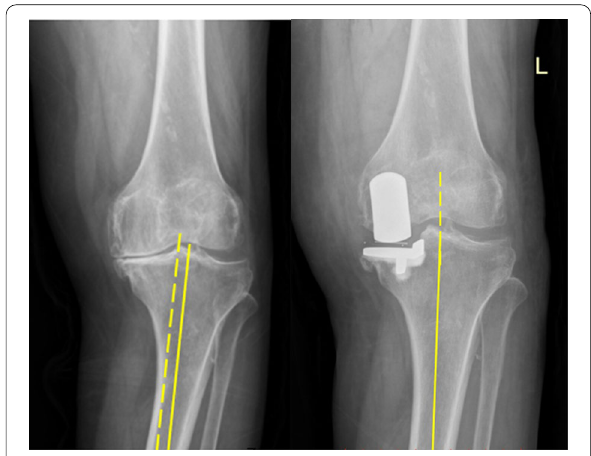
Fig. 3 Comparison of CTFS between the mild subluxation group and the severe subluxation